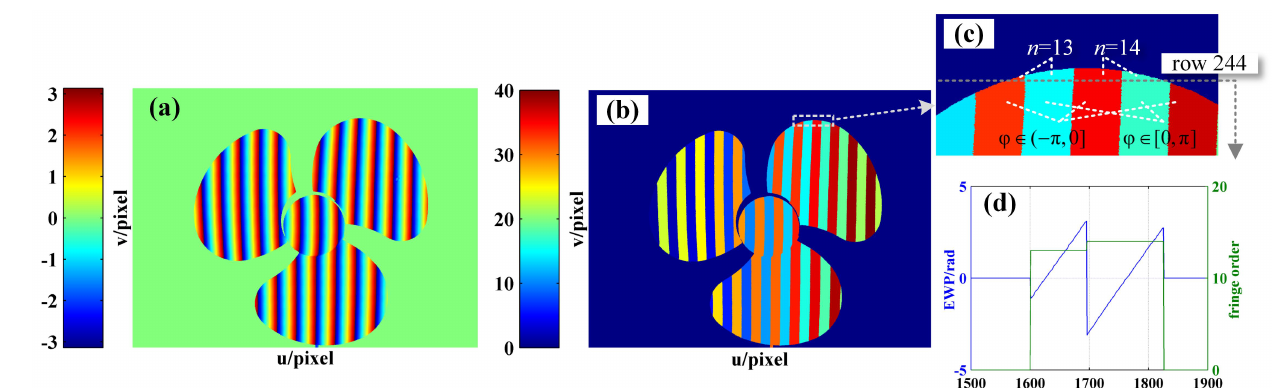
Figure 17. ( a ) EWP map; ( b ) identification result of semiperiodic connected regions; ( c ) enlarge view of ( b ) with u = [1500, 1900] and v = [150, 350]; ( d ) EWP and fringe order with u = [1500, 1900] of row 244 obtained using the proposed